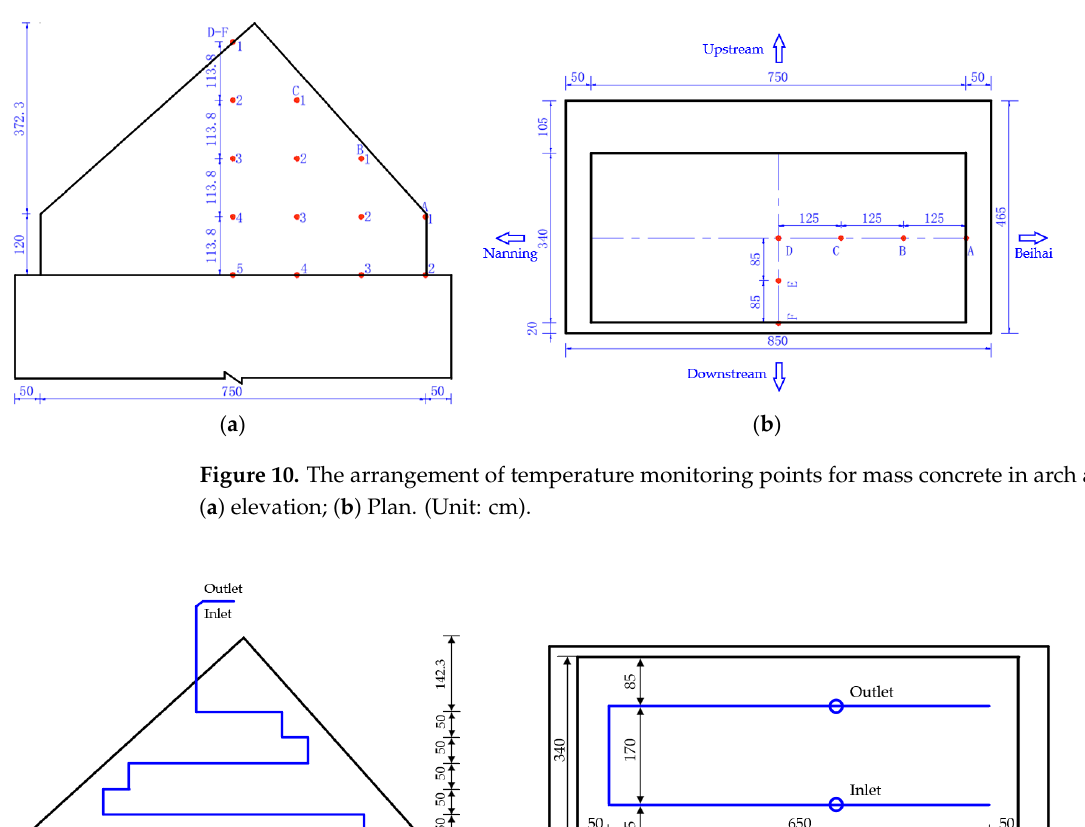
Figure 11. The cooling pipe layout of the arch abutment: ( a ) elevation; ( b ) plan (unit: cm). (f)